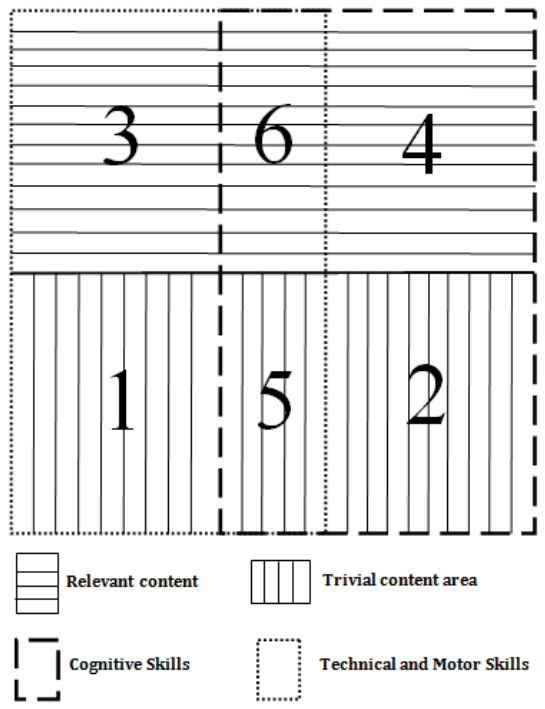
Figure 1. The model proposed for the identified learning